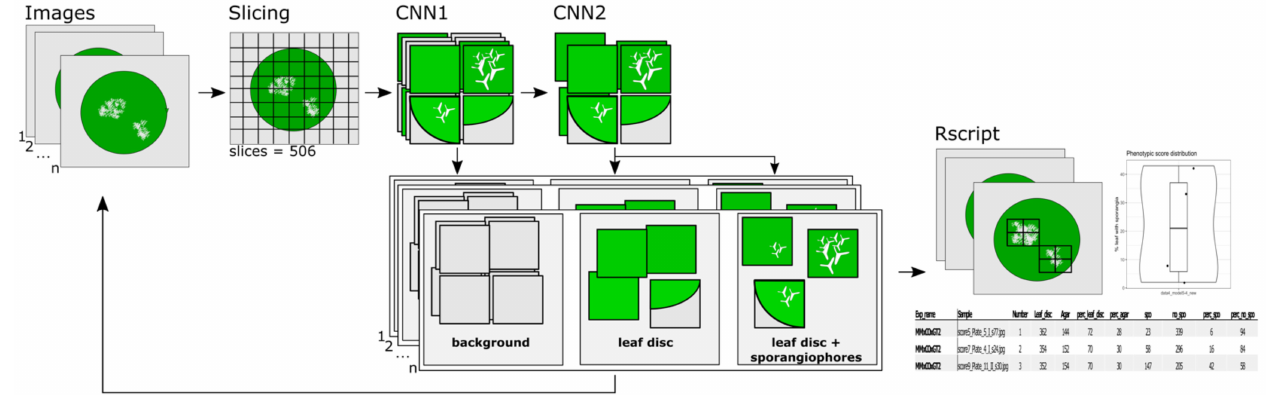
Figure 4. Scheme of the classification process of the two